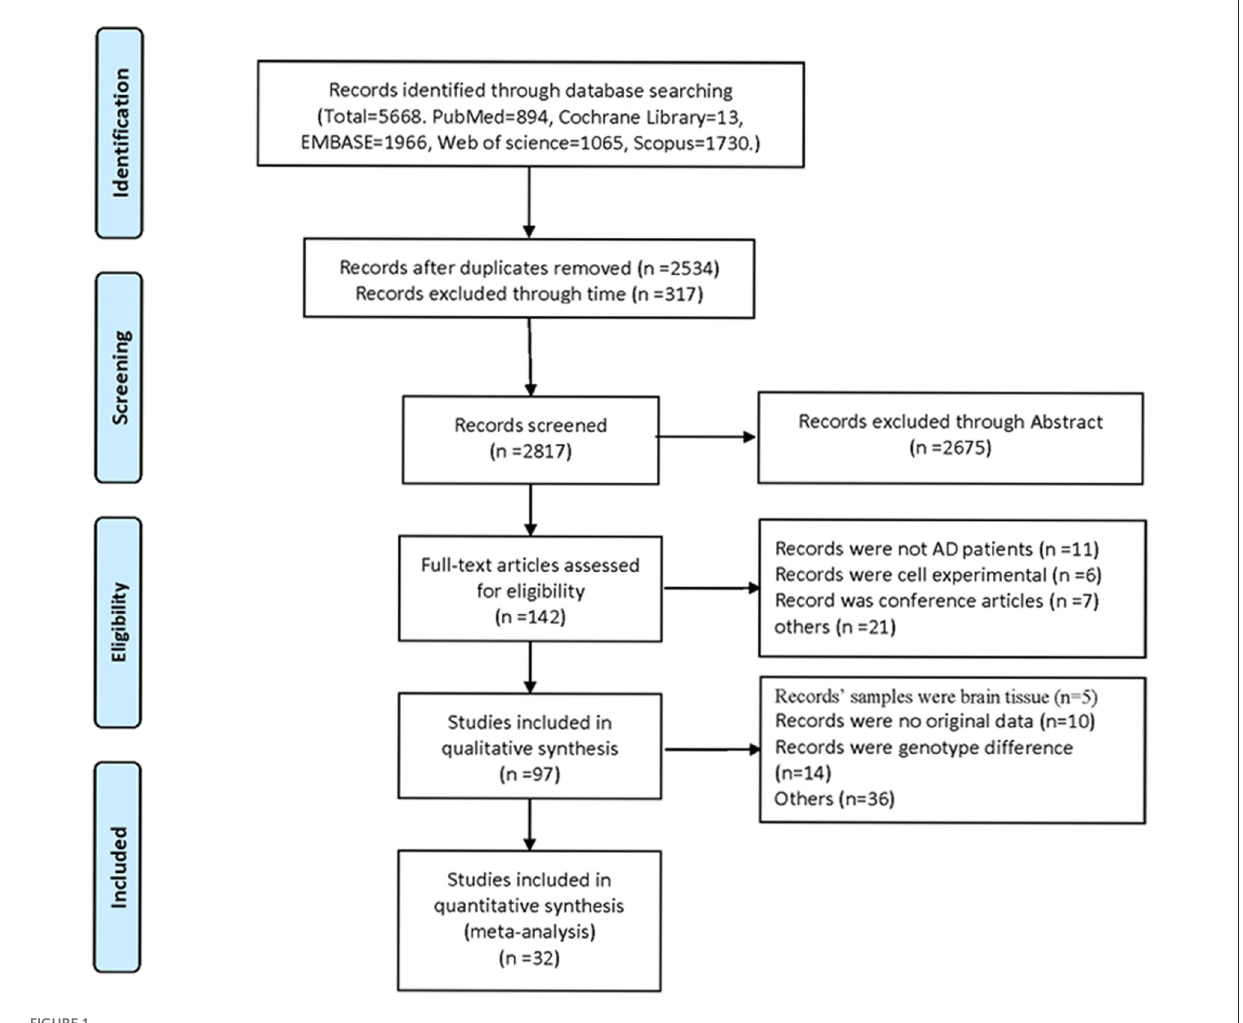
FIGURE1 Flowchart of meta-analysis retrieval literature